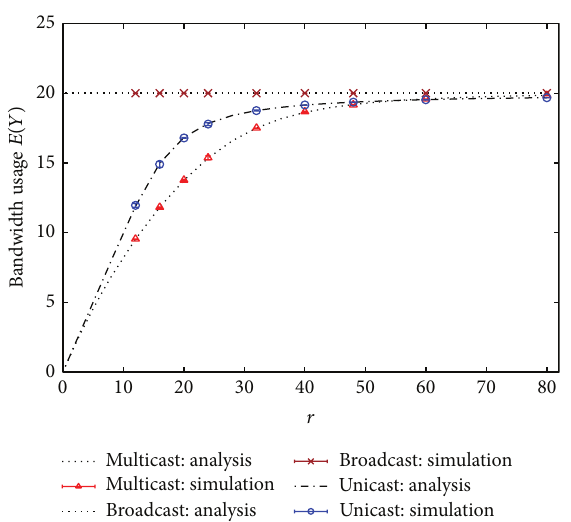
Figure 3: Bandwidth usages of unicast, broadcast, and multicast IPTV services. (Hit rate distribution: uniform.)